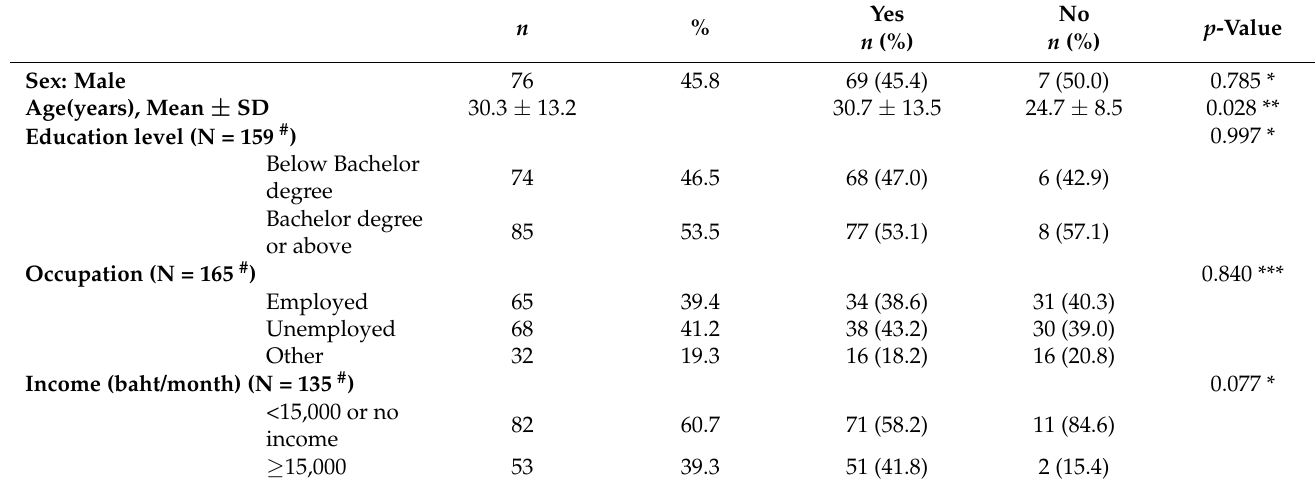
Table 5. Factors that affected practices to prevent dengue infection during the outbreak.